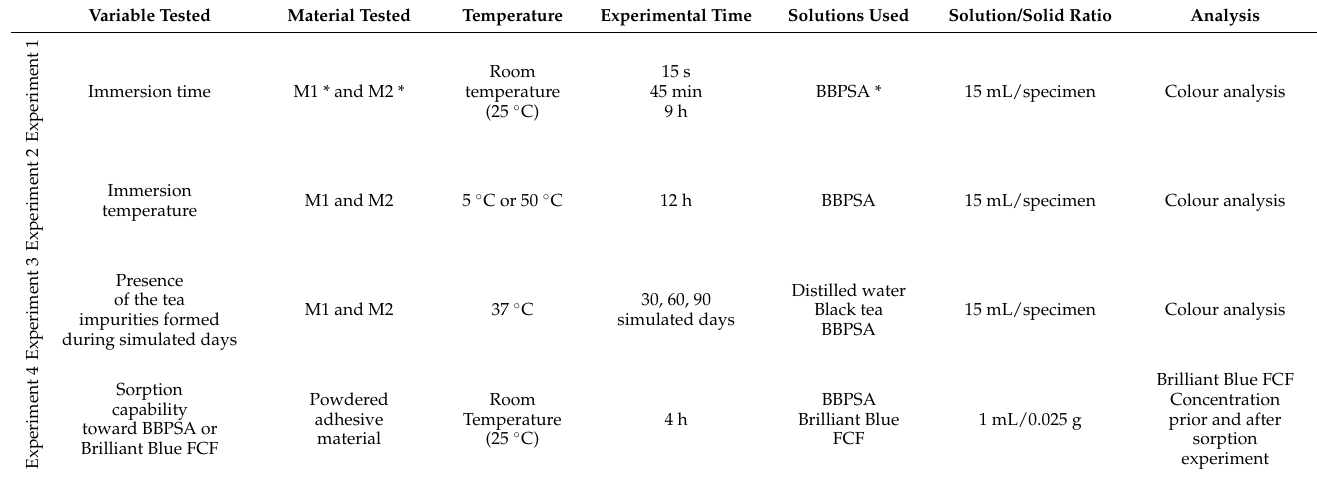
Table A1. Summary of the overview of the experimental setups.